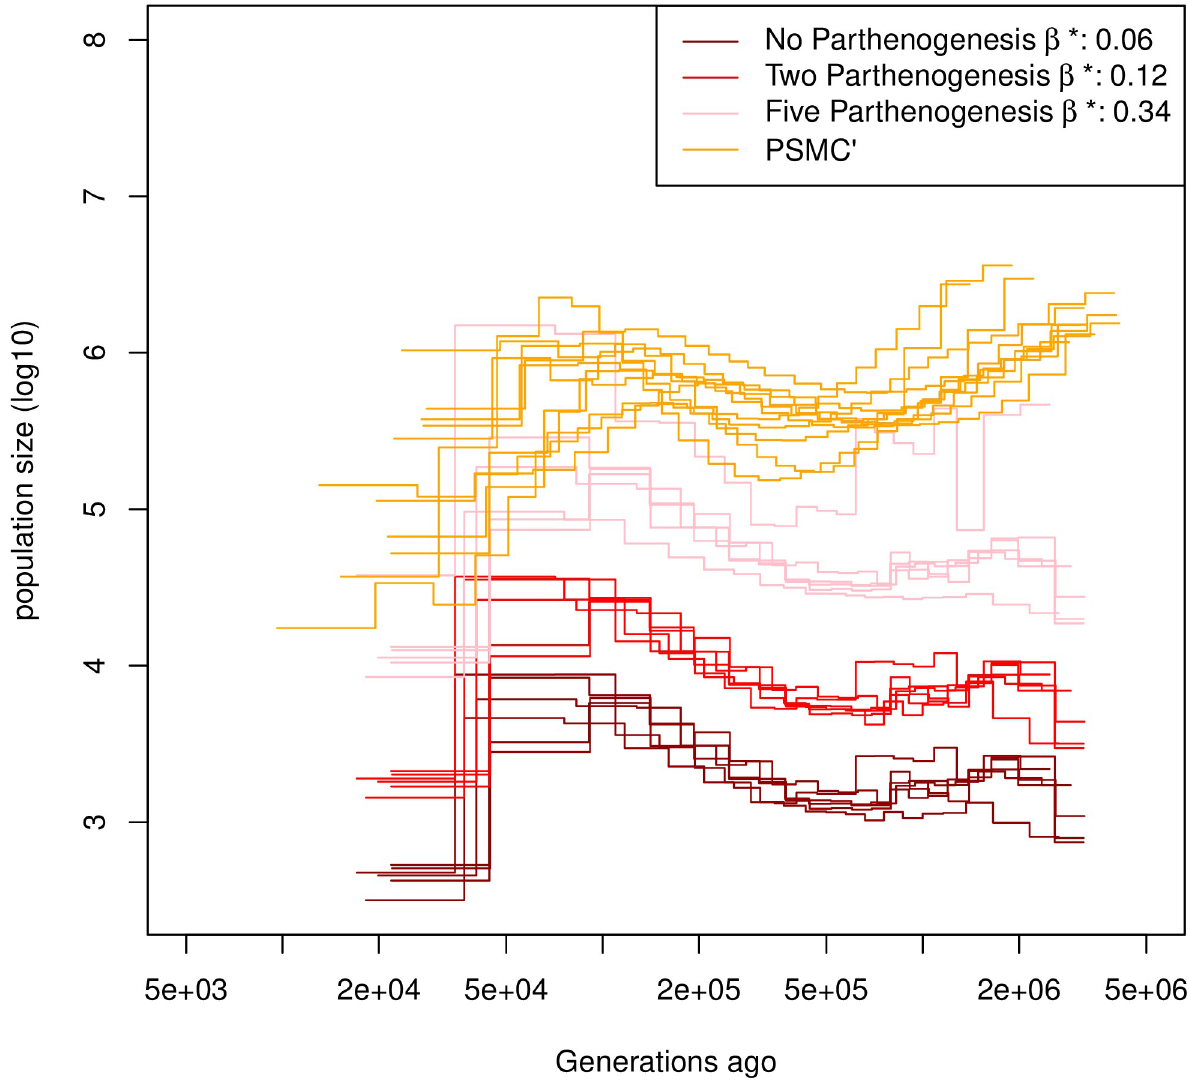
Fig 6. Estimated demographic history of Daphnia pulex . Demographic history estimated by eSMC on six individuals of D . pulex accounting for egg-banks ( β is a variable and σ = 0). Different assumptions concerning the number of parthenogenetic cycles before the production of the dormant egg are made: Five cycles (pink), two cycles (red) and no parthenogenesis (dark red). A subset of demographic history estimated by PSMC’ are plotted in orange. Mutation and recombination rates are respectively set to 4.33 × 10 − 9 and 8 � 10 (cid:0) 8 per generation per bp, where n p is the number of n p reproductive cycles per year, parthenogenetic and